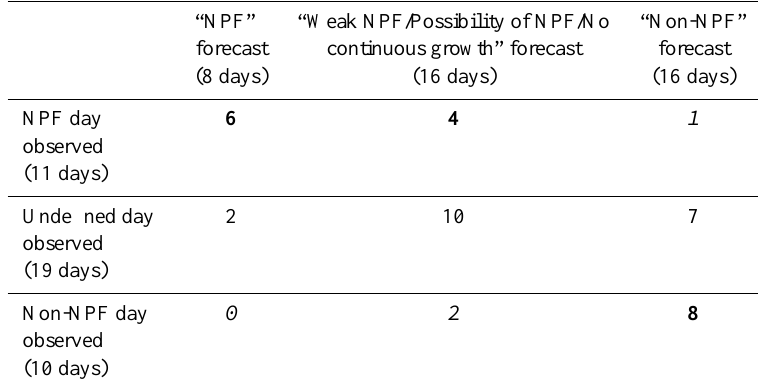
Table 4. Comparison of the NPF classification based on DMPS data (rows), and the NPF forecasts (columns). On days marked in bold the forecasts were successful in predicting whether NPF occurred in Hyytiälä or not, and on days marked in italic the forecast was wrong according to observations. The days classified as undefined according to observations are left out of the comparison with